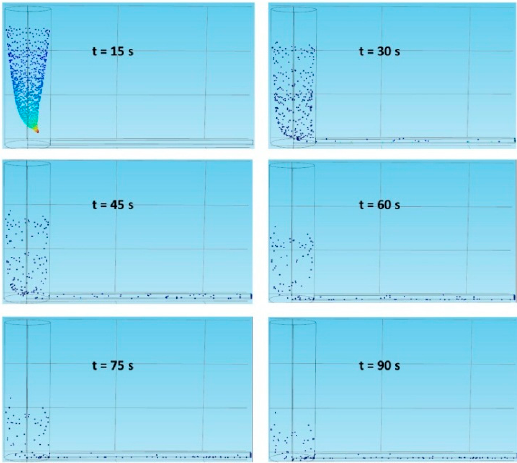
Figure 3. The particle trajectories in the vertical inlet under the Freeze wall condition at a flow velocity of 0.0001 m/s. Table 1. Different flow velocities and corresponding mass flow rates used in the simulation. Calculated shear stresses are also listed.